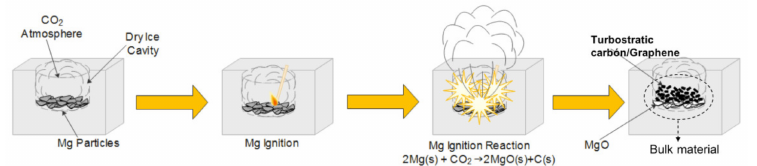
Figure 1. Descriptive diagram of the synthesis route to obtain turbostratic